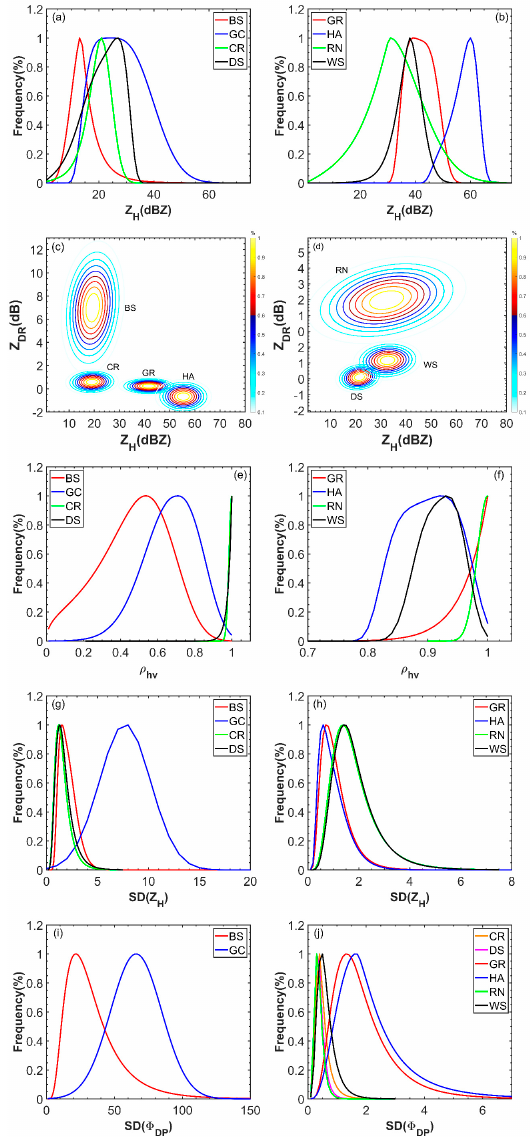
Figure 1. Conditional probability distribution functions (PDFs) fitted with Equations (3)–(6) for polarimetric radar variables: ( a , b ) Z H ; ( c , d ) Z H –Z DR ; ( e , f ) ρ hv ; ( g , h ) SD(Z H ); and ( i , j ) SD( Φ DP ).